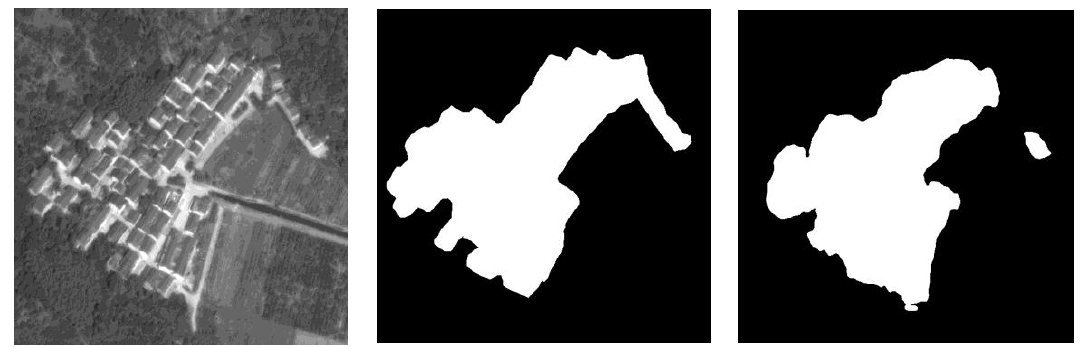
Figure 2. Built-up area detection results for part of the ZY-3